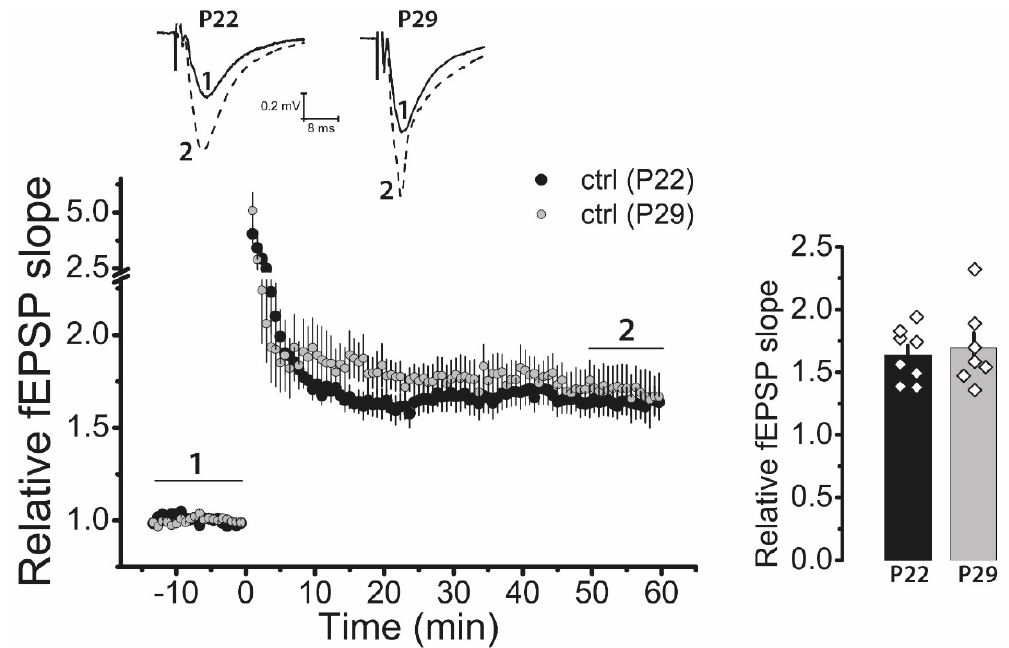
Figure A1. Astrogliosis in the rat hippocampus following pilocarpine-induced SE. Immunohistochemistry targeting glial fibrillary acidic protein (GFAP) was used for the detection of astrocytes. Representative images of hippocampal sections with GFAP-positive cells and their corresponding black–white masks were obtained with ImageJ software and used for area counting (upper panels: × 5 magnification and lower panels: × 40 magnification).